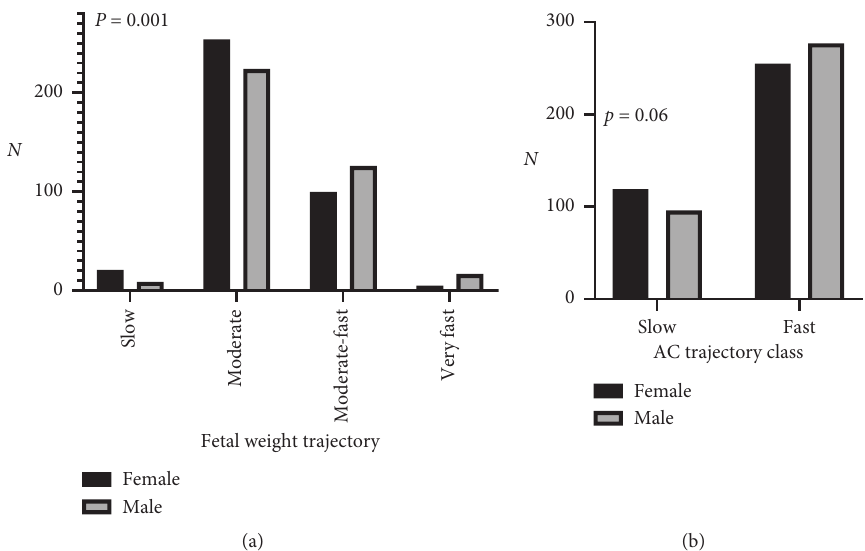
Figure 1: (a) Fetal growth trajectory (slow, moderate, moderate-fast, very fast) and association with fetal sex. (b) Abdominal circumference (slower and fast) and association with fetal sex.